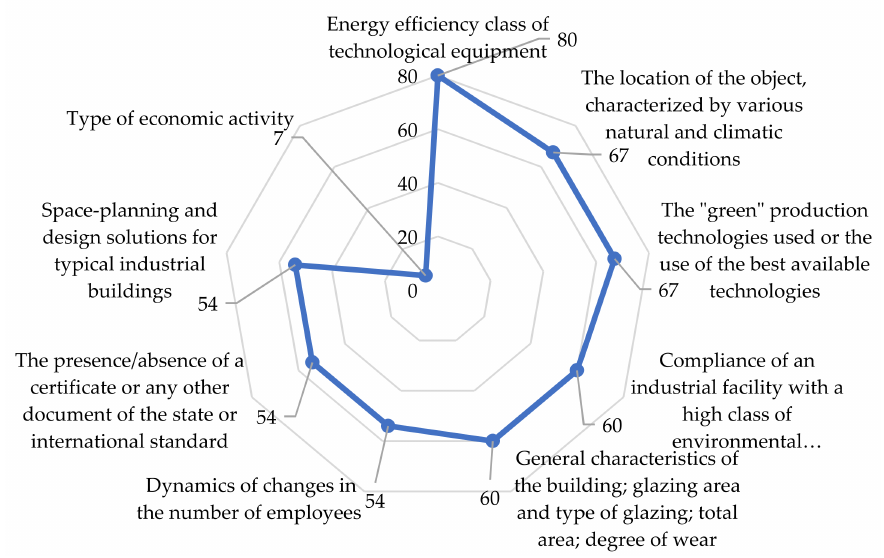
Figure 3. Distribution of expert opinions on the importance of conditions for ensuring energy efficiency of an industrial facility, % of